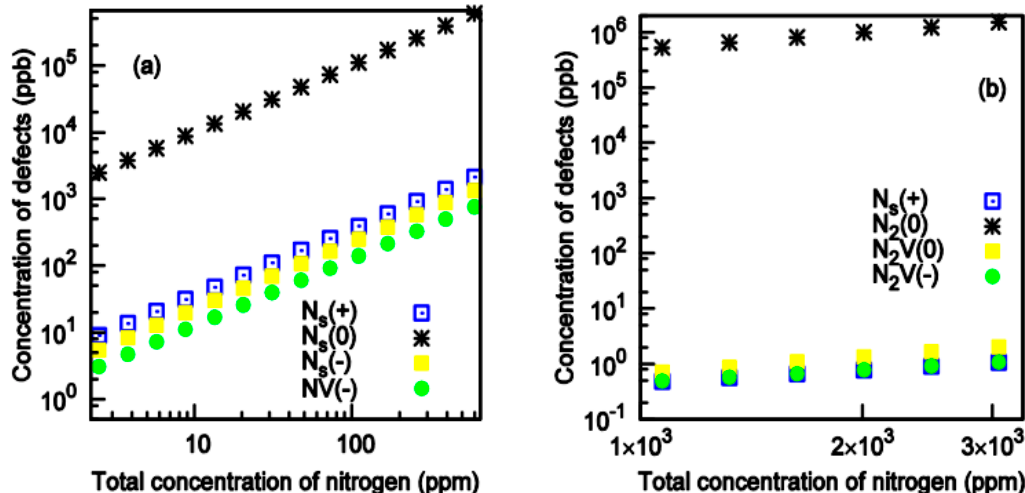
Figure 3. Defect concentrations over a wide range of initial nitrogen concentration in diamond lattice after performing annealing treatment at 1100 K. ( a ) shows the concentration of Ns(+), Ns(0), Ns( − ), and NV( − ) defects and ( b ) shows the concentration of Ns(+), N 2 (0), N 2 V(0), and N 2 V( − ) defects. Ns: substitutional nitrogen. Reprinted with permission from De á k, P.; Aradi, B.; Kaviani, M.;